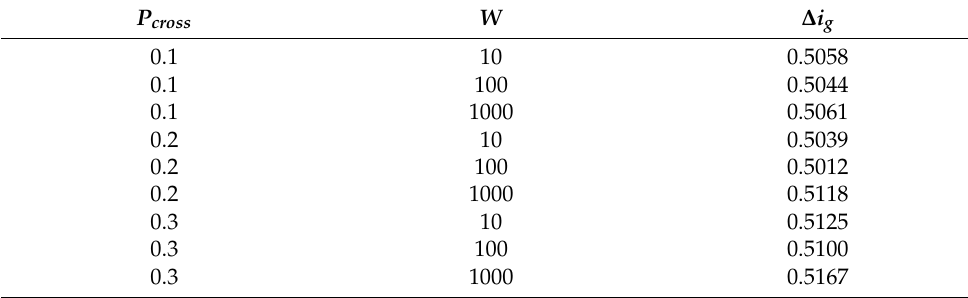
Table 1. Obtained results from the sensitivity test considering G = 5.